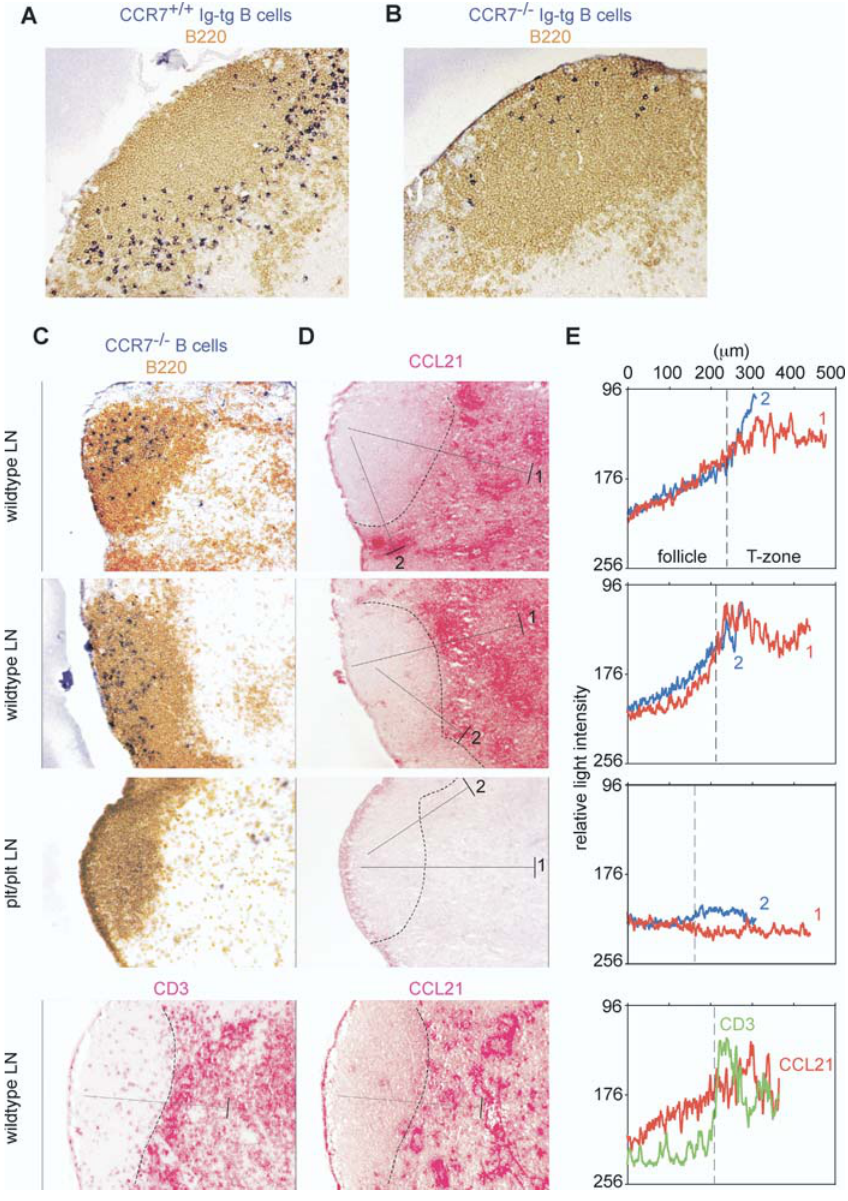
Figure 3. CCL21 Concentration Gradients in B Cell Follicles in Lymph Nodes (A and B) Lymph node sections of wild-type mice that received CCR7 þ / þ Ig-tg (A) or CCR7 (cid:1) / (cid:1) Ig-tg B cells (B) and 1 mg of HEL intravenously for 6 h, stained to detect all B cells (brown) and HEL-binding B cells (blue). (C) B cell (upper three panels) or T cell (lower panel) staining of lymph node sections from wild-type and plt/plt mice as indicated. The wild-type lymph nodes shown in the upper panels were from Igh a mice that had received CCR7 (cid:1) / (cid:1) Igh b B cells 1 d before. Staining was to detect all B cells (B220, brown) and transferred CCR7 (cid:1) / (cid:1) B cells of the Igh b allotype (dark blue) or T cells (CD3, red) as indicated. (D and E) Detection of CCL21 concentration gradients in follicle. In (D), adjacent sections were stained for CCL21. The dashed lines indicate the B/T boundary determined by the distribution of B220 staining. The pixel intensity at each position along the filled line extending from the follicle into the deep T zone (line 1) or the interfollicular T zone (line 2) was averaged across 50 l m perpendicular to the line (the width shown by the bar at the T zone end of each line) and plotted against distance from the follicular end of the line (E) in red for line 1 and blue for line 2. As a negative control, the pixel intensity was determined along a line located in the equivalent location in a CD3-stained section (bottom panel of [C] and shown as a green line in [E]). Pixel intensity was measured using Metamorph software after converting colored pixels to gray scale. A decrease in transmitted light intensity indicates an increase in CCL21. Data are representative of more than five lymph nodes from two mice of each type. DOI: